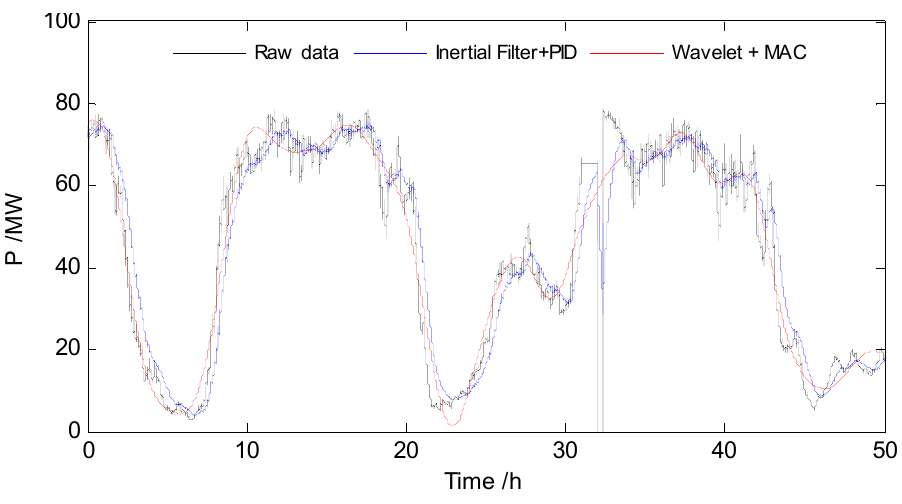
Figure 16. The power smoothing control curves combining Inertial Filtering with PID and combining Wavelet Transform with